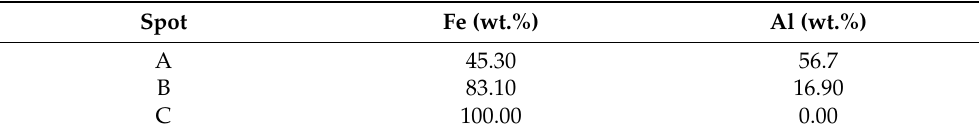
Figure 8. Detailed cross-section analysis of the substrate/coating interface by SEM/EDS after heat treatment at 550 °C for 96 h (BSE imaging mode): coating (spot A), interface layer (spot B) and substrate (spot C). Table 1. Composition of EDS spots indicated in Figure 8 (values in relative weight